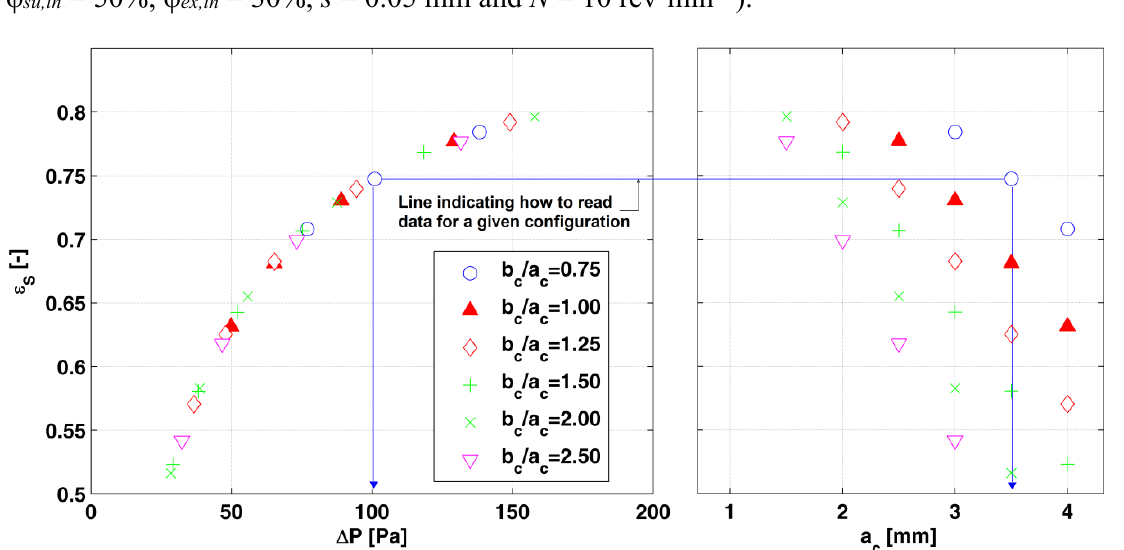
Figure 8. Optimal heat wheel configurations at L = 0.2 m and at v f = 2.5 m·s −1 for different channel height and base ( T su,in = 10 °C, T ex,in =30 °C, X su,in = 3.7 g·kg −1 , X ex,in = 7.7 g·kg −1 , φ su,in = 50%, φ ex,in = 30%, s = 0.05 mm and N = 10 rev·min −1